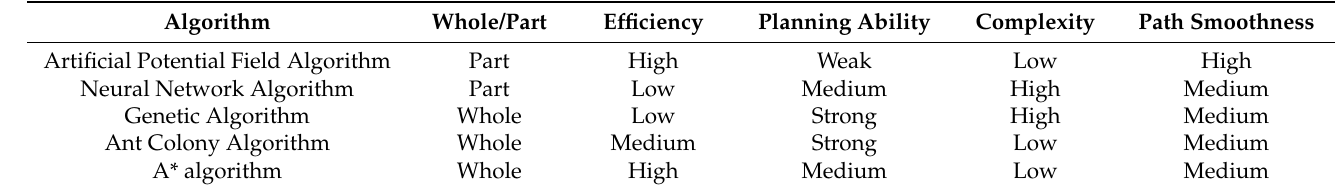
Table 3. Comparison of mainstream path planning calculations